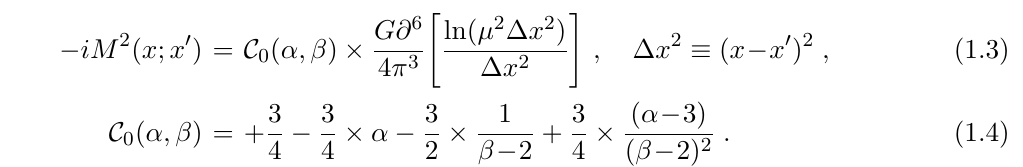
The renormalized self-mass is